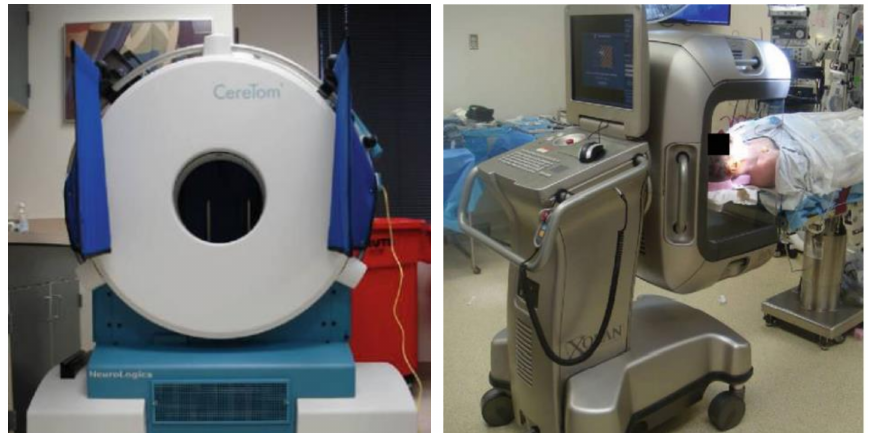
Figure 3. Portable head CT scanners: CereTom (left) and xCAT (right). Figure has been reprinted with permission from Springer Nature, Int J CARS, “Evaluation of portable CT scanners for otologic image-guided surgery”, Balachandran et al, copyright 2012 [29].